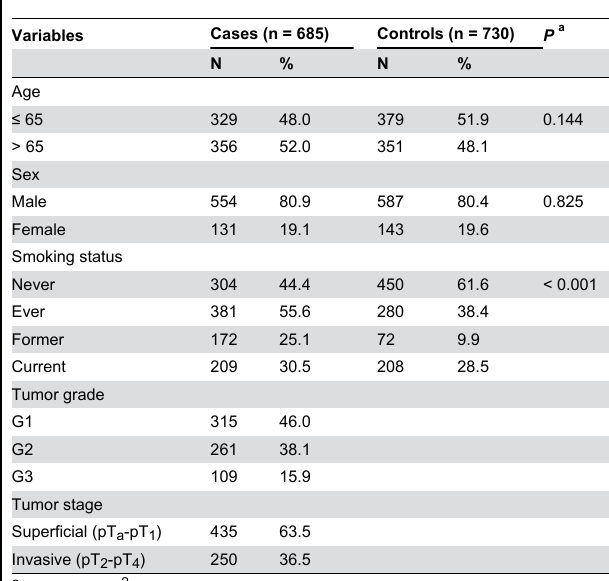
Table 2. Frequency distributions of selected variables between the bladder cancer cases and cancer-free